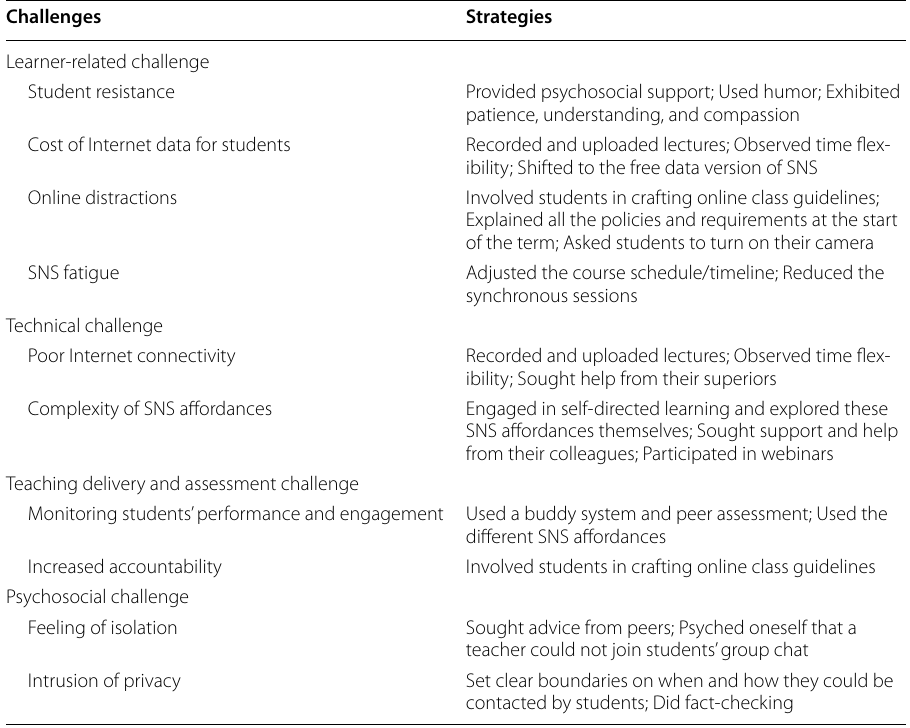
Table 2 Summary of teachers’ challenges and